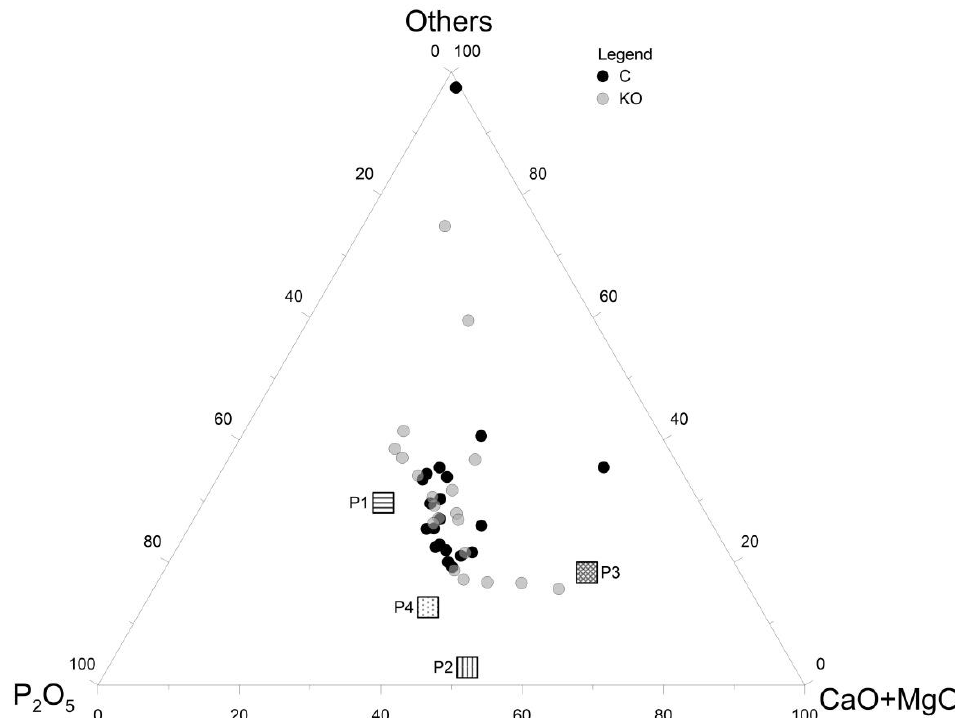
Figure 6. Chemical composition of selected ash grains in the samples of ash obtained in experiment E3 determined by the EDS method. ( a ) Chemical composition of selected ash grains in sample E3/C. ( b ) Chemical composition of selected ash grains in sample E3/KO. (centre line—median, box edges—percentiles 25%/75%, whiskers—minimum/maximum) and XRF method (spot) (note: element C was excluded from the analysis).